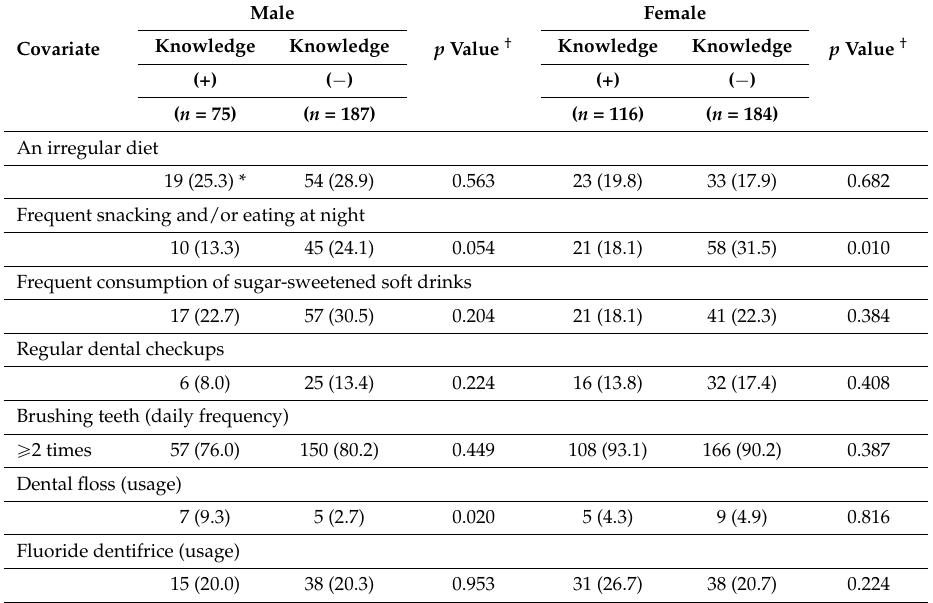
Table 2. Association between knowledge about comprehensive food education ( shokuiku ), dietary habits, and oral health